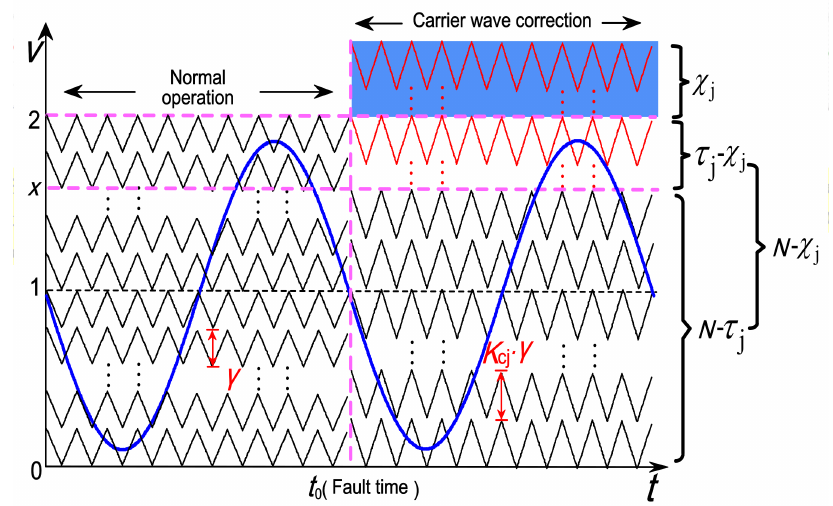
Figure 6. Modulation diagram of the faulty phase under carrier wave